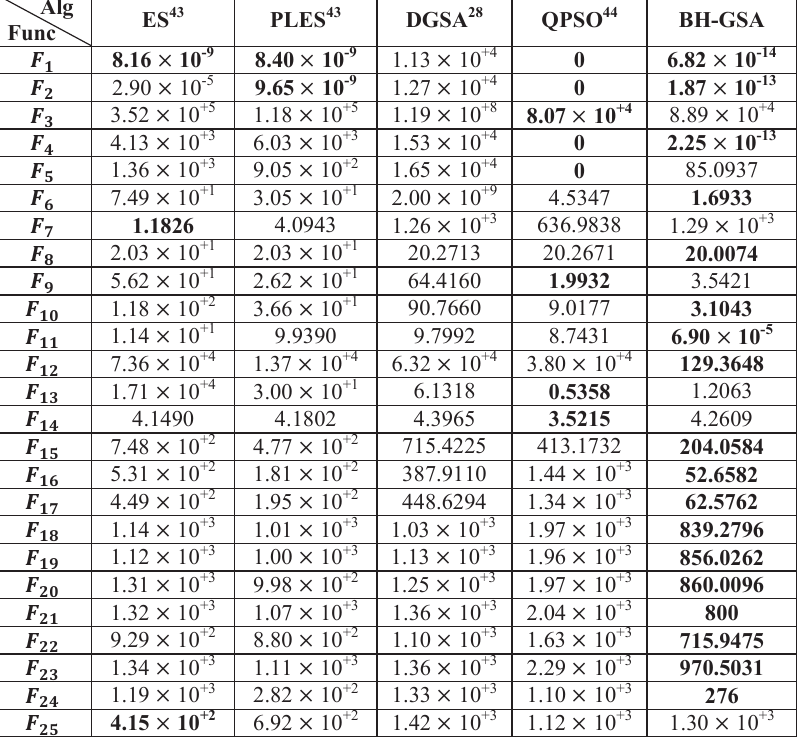
Table 14. The comparison of BH-GSA with other algorithms (n=10).